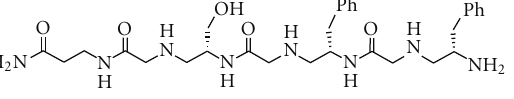
Figure 4: Structure of SFF